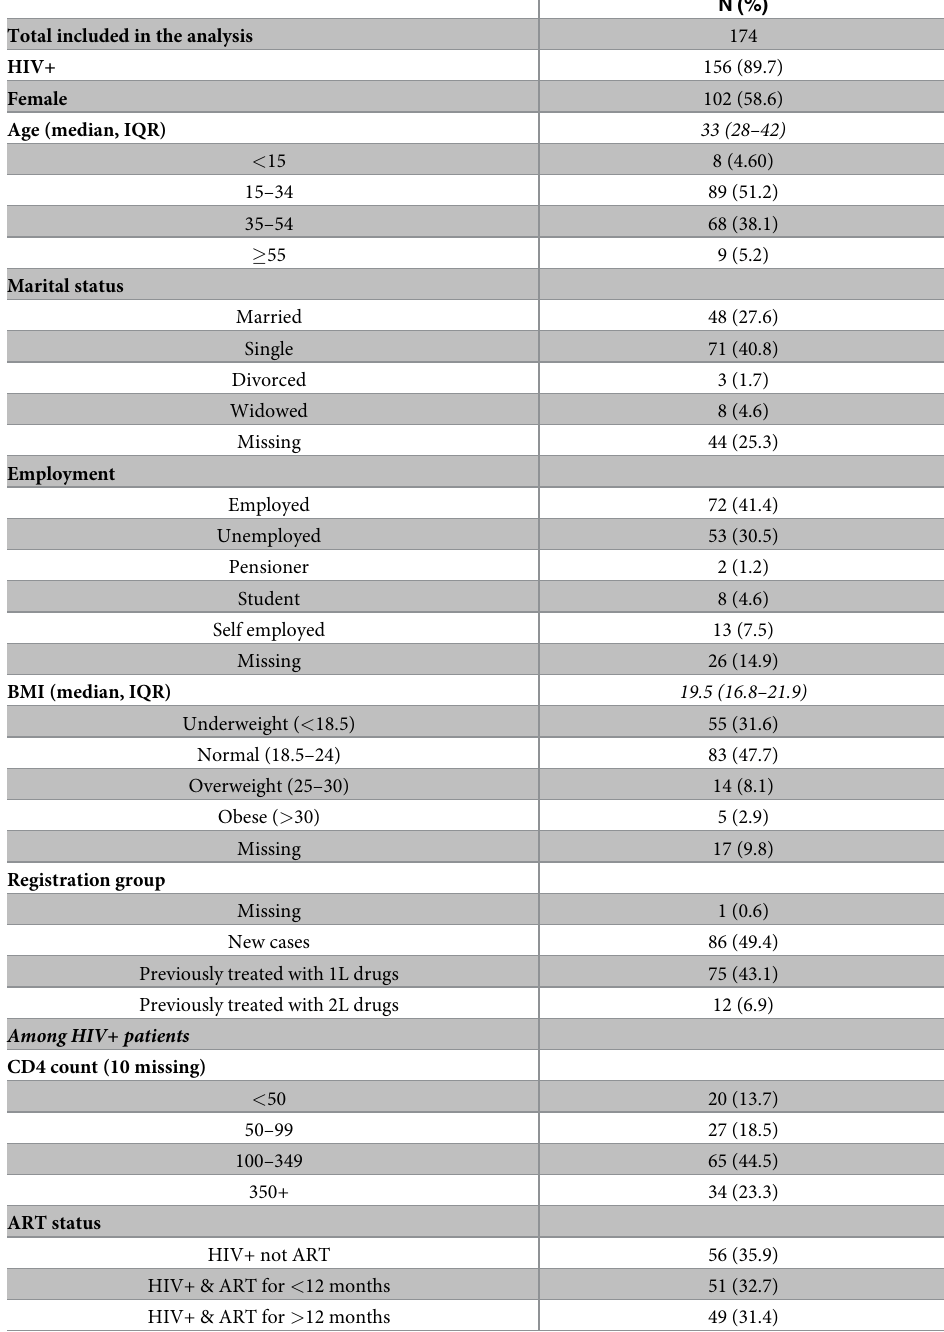
Table 1. Demographic and key baseline